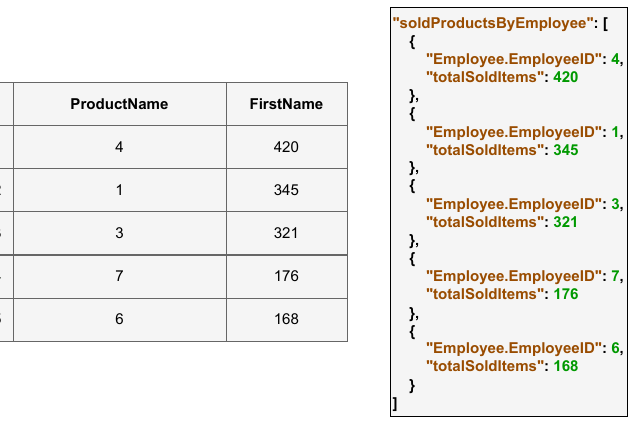
Figure 10. Query output for Q3. Left : Source database (Postgres). Right : Target database